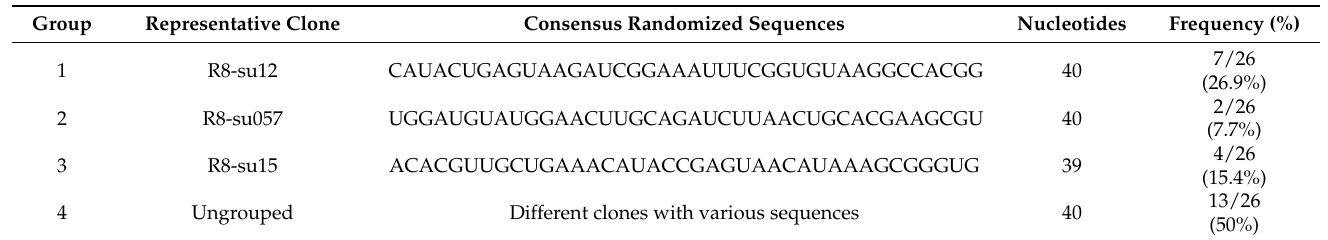
Table 1. Summarization of consensus randomized sequences of the RNA R8 aptamer pool.